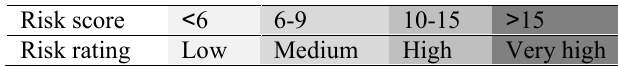
Table 2. Risk Assessment Matrix Interpretation